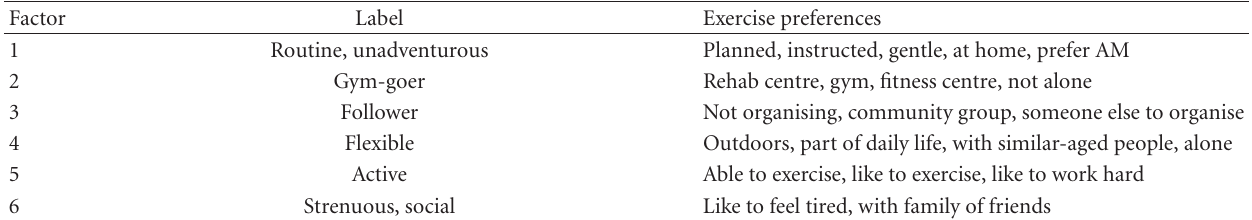
Table 4: Data-driven factor